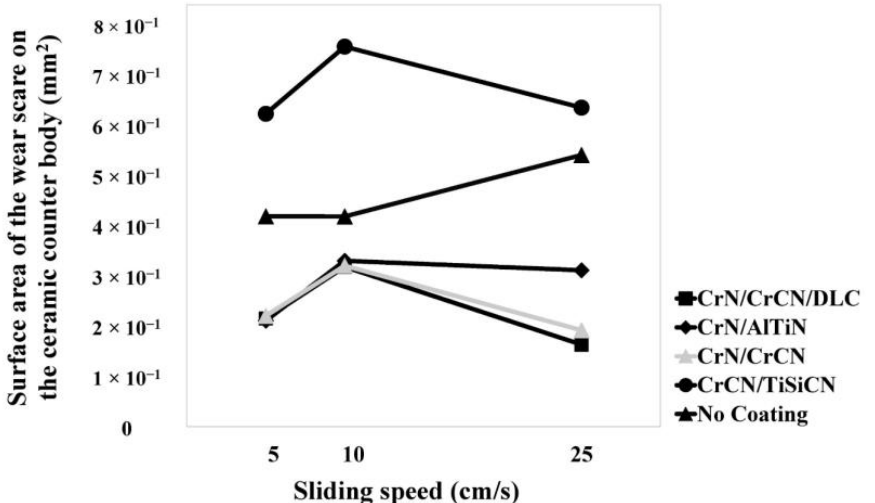
Figure 20. Wear scar area on the ceramic ball as a function of sliding speed.